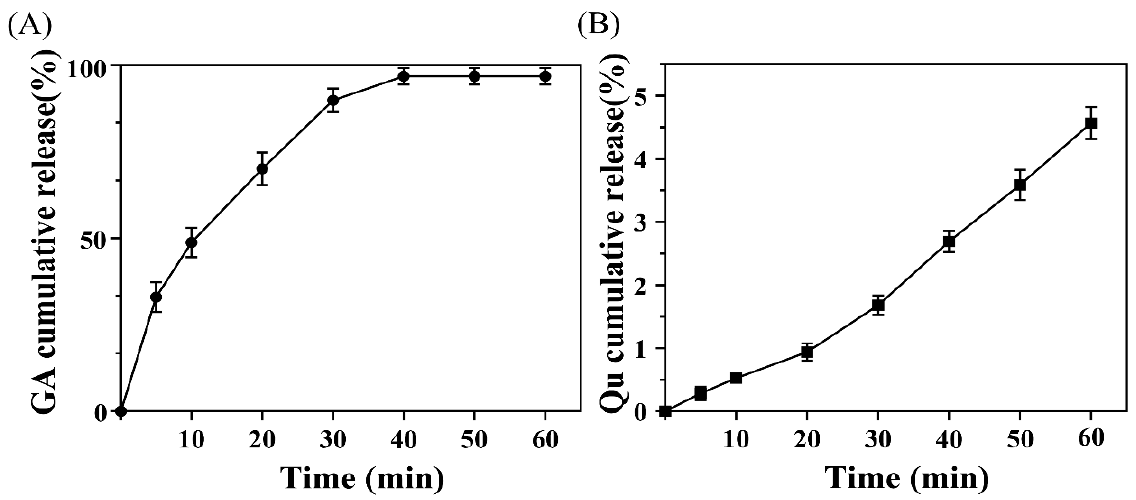
Figure 6. Drug permeation profiles of MN patches: ( A ) GA release curve; ( B ) Qu release curve (mean ± SD, n = 5).